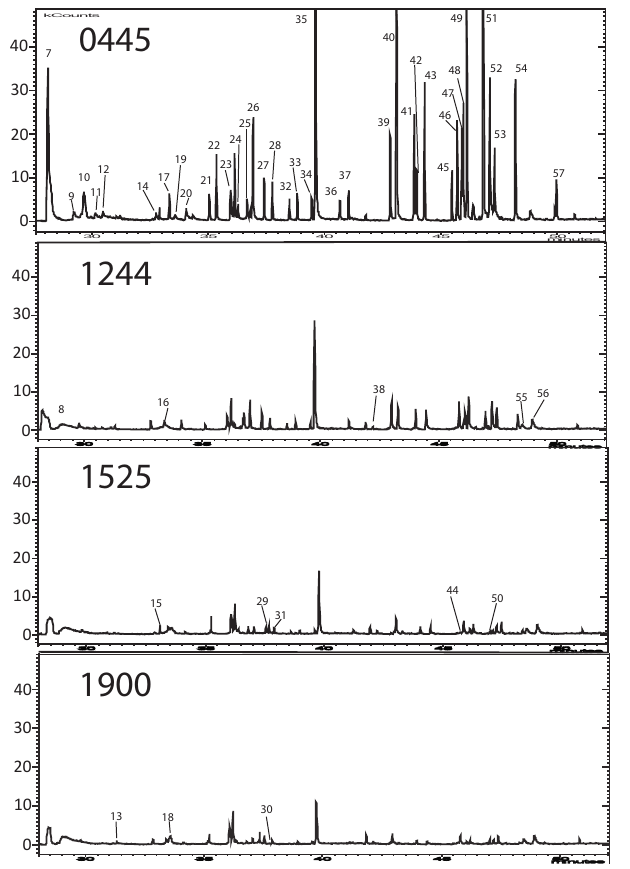
Fig. 5. FID chromatograms of VOCs during the experiment III (JN2509) using SynUrb54/NO x mixture. Numbers labeling the species in the chromatograms correspond to the identification num- bers in Table 4 and the time of sample corresponds to the red circles in Figs. 2, 3, and 4.